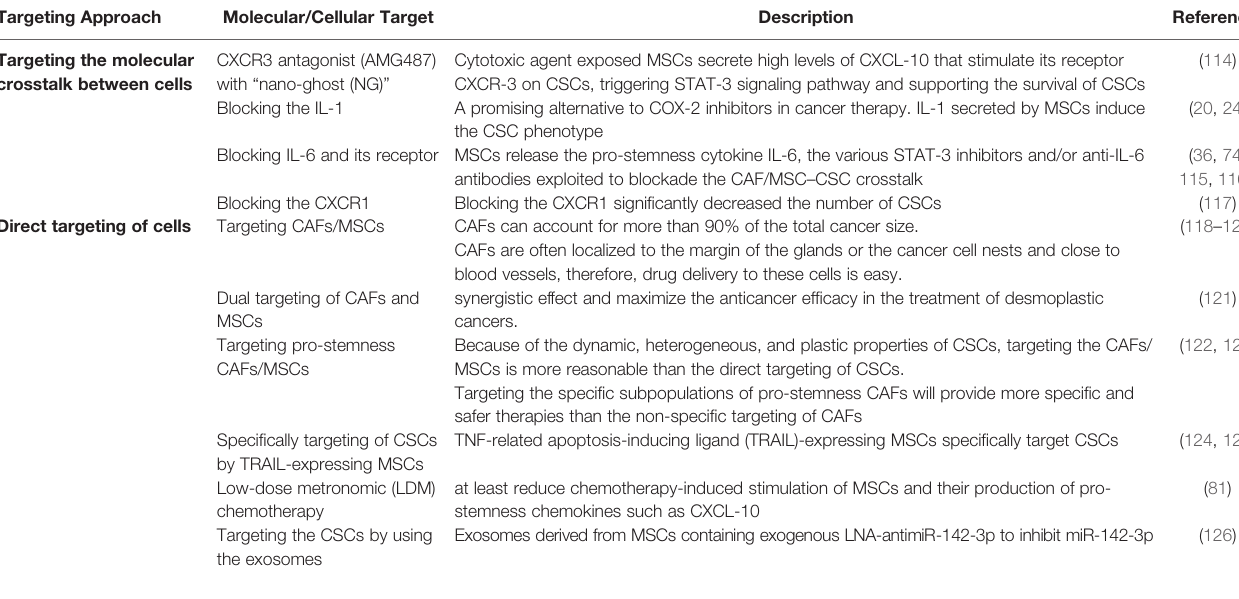
TABLE 1 | Targeting approaches of crosstalk between MSCs and